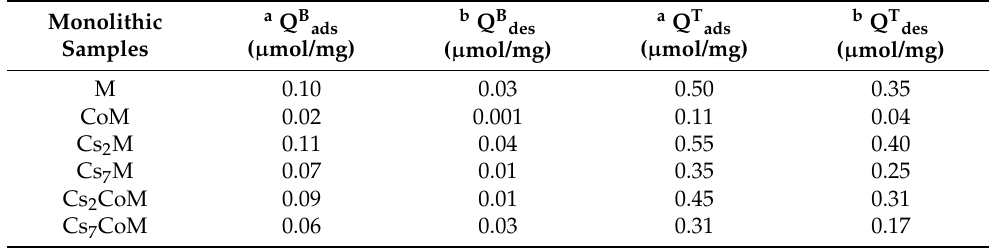
Table 2. Adsorption and desorption capacities of toluene and butane mixture on monolithic adsorbents.